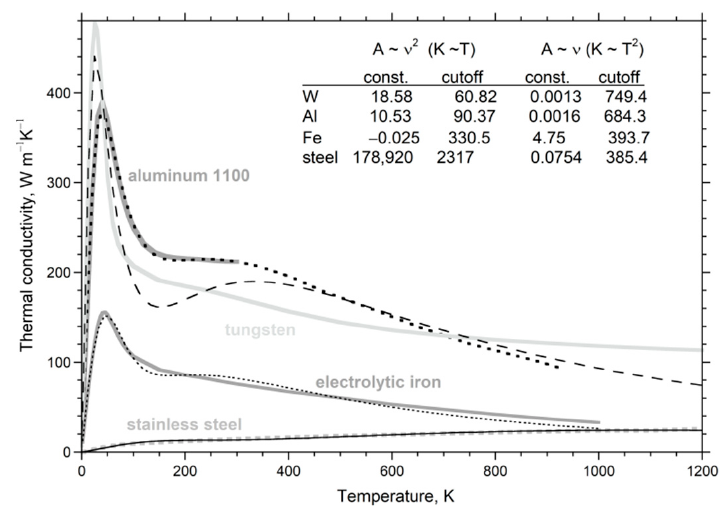
Figure 16. Fits to various metals using the radiative diffusion model with two mechanisms. We assumed A ~ ν 2 for the infrared region and A ~ ν for the near-IR. Parameters are listed in the inserted table. If κ had been non-dimensionalized, only 3 parameters would be needed. Fits are in black. Data (grey) are from Hust and Lackford [24], except for Al from Bradley and Radebaugh [106]. Al-1100 is an alloy with about 1% impurities, usually Si or Fe. Tungsten is sintered, with non-negligible porosity. Modified after Figure 11.10 in Hofmeister [4], with permission from Else- vier.